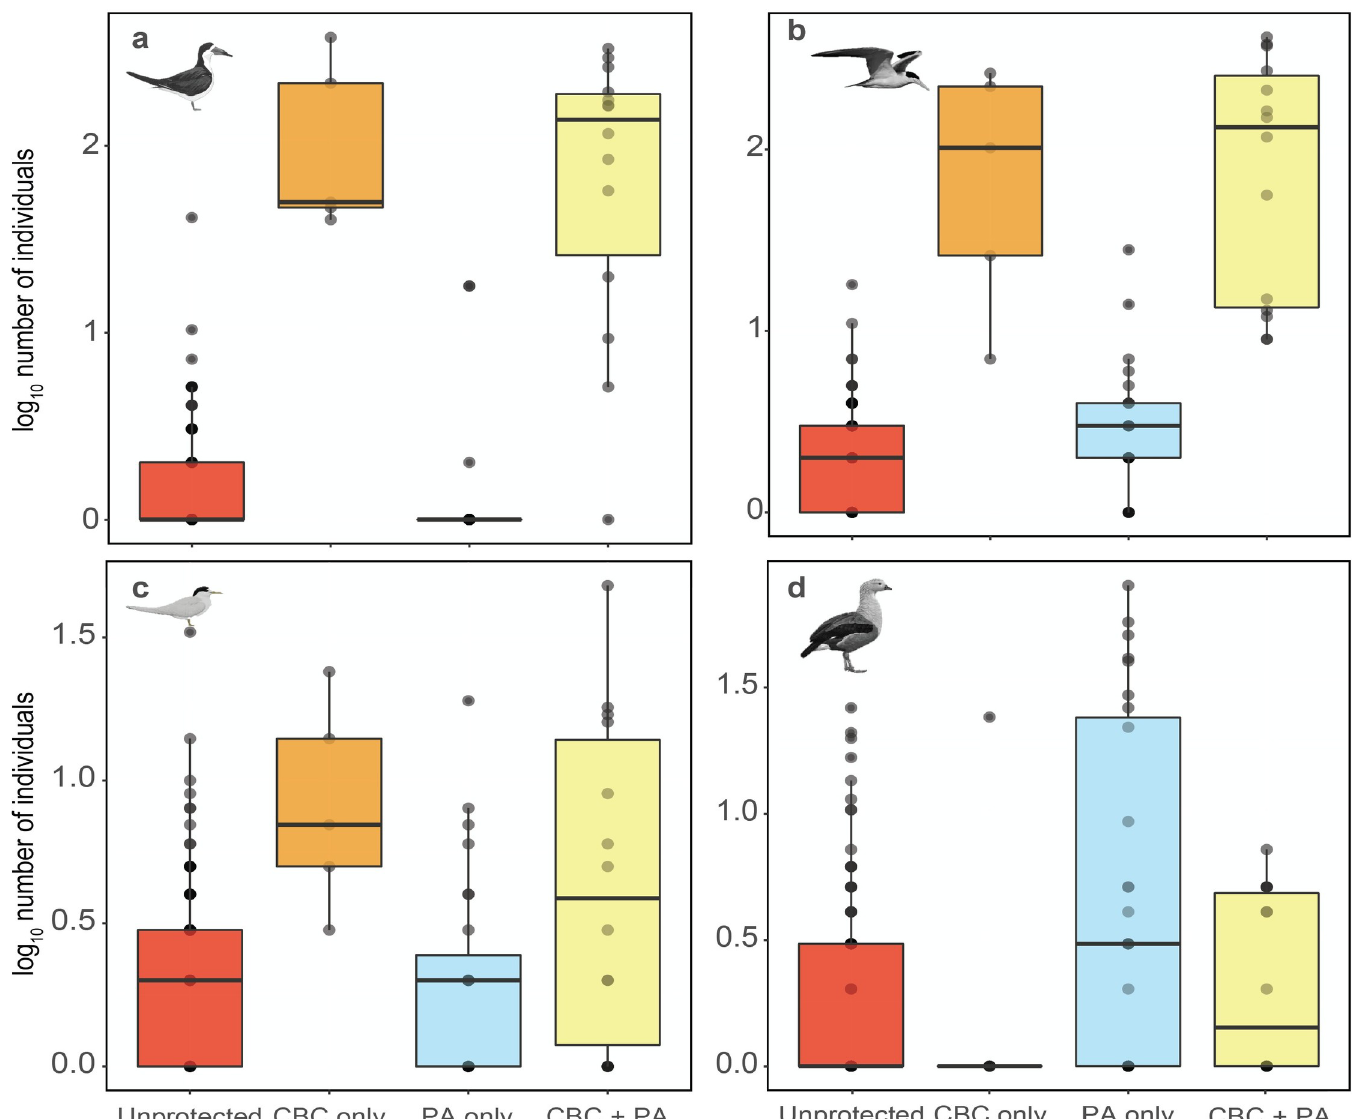
Fig 3. Box plots showing the number of individuals of four waterbird species surveyed along the Jurua ´ River under different protection regimes. (A) Black Skimmers; (B) Large-Billed Terns; (C) Yellow-Billed Terns; and, (D) Orinoco Geese. Red, orange blue and yellow boxes represent beaches that are; unprotected; under Community-Based Conservation but outside Protected Areas (CBC-only); inside a PA but without CBC (PA-only); and, under CBC inside a PA (CBC + PA), respectively.